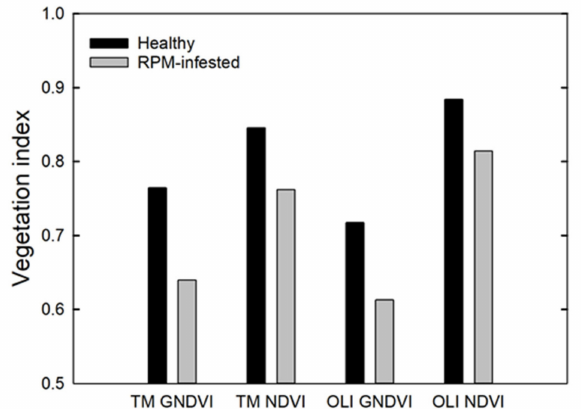
Figure 4. Predicted Green Normalized Di ff erence Vegetation Index (GNDVI) and Normalized Di ff erence Vegetation Index (NDVI) for Landsat 5-Thematic Mapper (L5-TM) and Landsat 8 Operational Land Imager (L8-OLI) based on simulated canopy reflectance spectra of healthy and damaged coconut palms simulated using the PROSPECT and SAIL model.